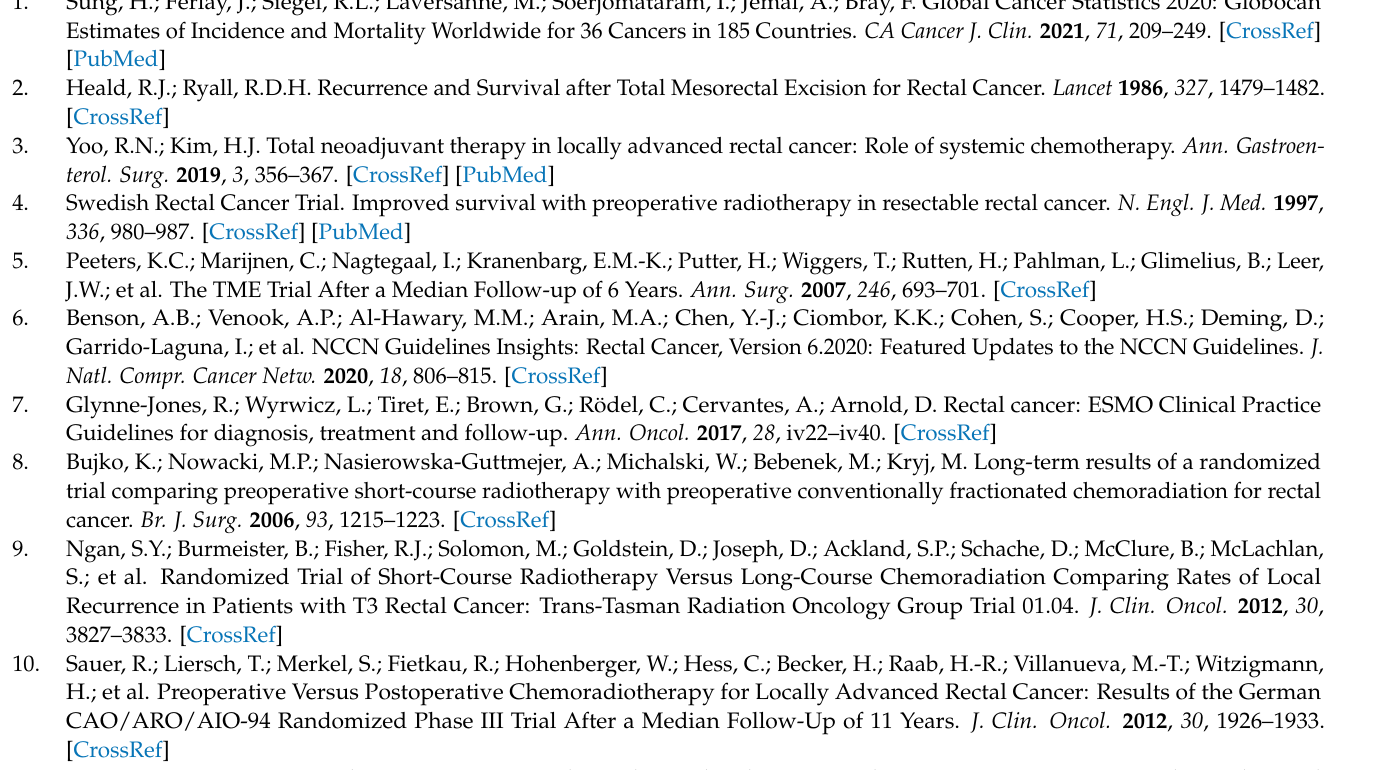
Figure S3. Forest plot of ypN0 rate after neoadjuvant treatment. Figure S4. Forest plot of the rate of local recurrence. Figure S5. Forest plot of the rate of distant metastasis. Figure S6. Forest plot of the R0 resection rate. Figure S7. Forest plot of the negative circumferential resection margin (CRM) rate. Figure S8. Forest plot for the rate of postoperative complications. Figure S9. Forest plot of the rate of acute toxicity. Figure S10. Forest plot of (A) the rate of late toxicity (B) the compliance of